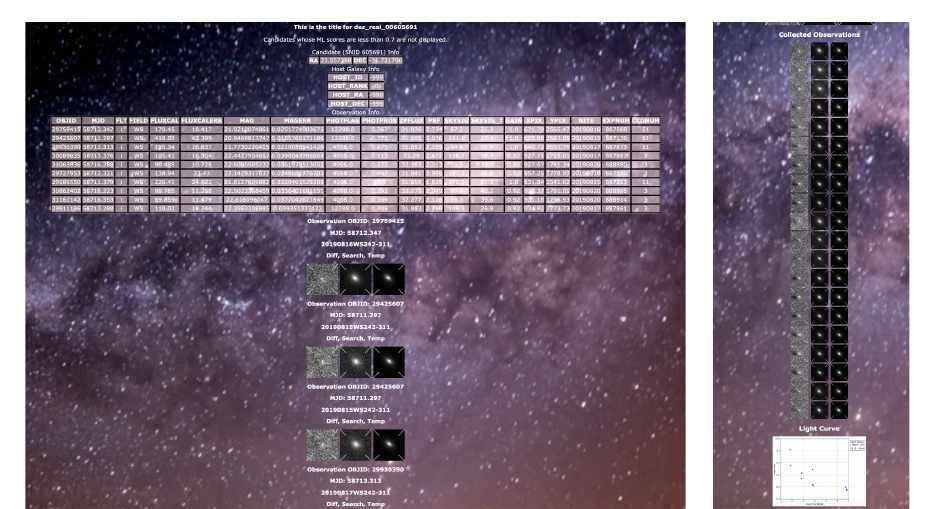
Figure 6. Example web page for a single EM counterpart candidate. The page provides a sky loca- tion, the time, magnitude, and observing condition information for each observation of the candidate (left panel). Also shown are image cutouts or "stamps" from the template, search, and di ff erence im- age for each observation (left panel). Continuing down the page (right panel), one finds the collected observations presented together along with a light curve plot for the